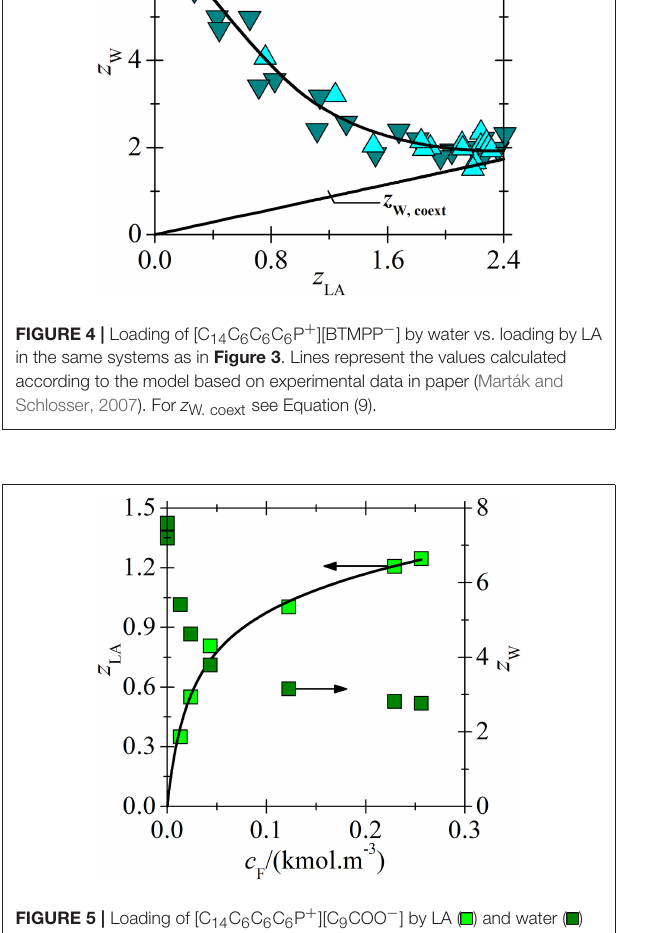
FIGURE 5 | Loading of [C 14 C 6 C 6 C 6 P + ][C 9 COO − ] by LA ( ) and water ( ) vs. equilibrium LA concentration of undissociated LA in the aqueous phase in system (water + undiluted [C 14 C 6 C 6 C 6 P + ][C 9 COO − ]). The line correlates experimental data according to the model. Loading of IL by water was not correlated because of insufficient number of data